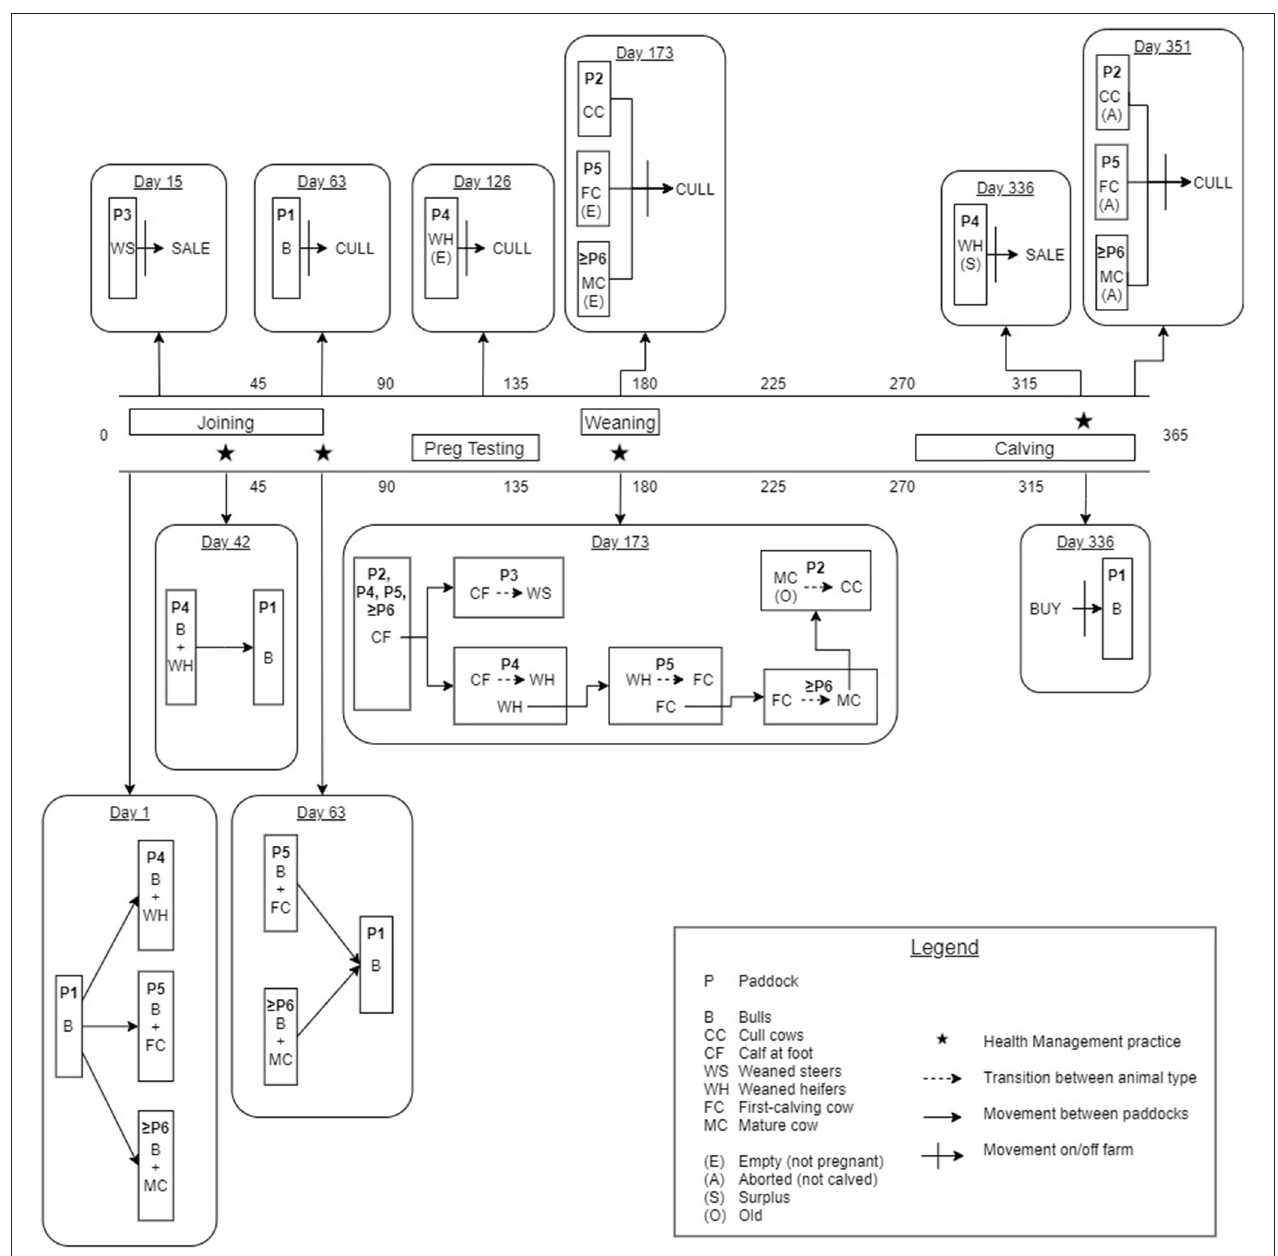
FIGURE 1 | Schematic of the annual production calendar, animal movements and transitions between animal groups for the simulated beef herd.